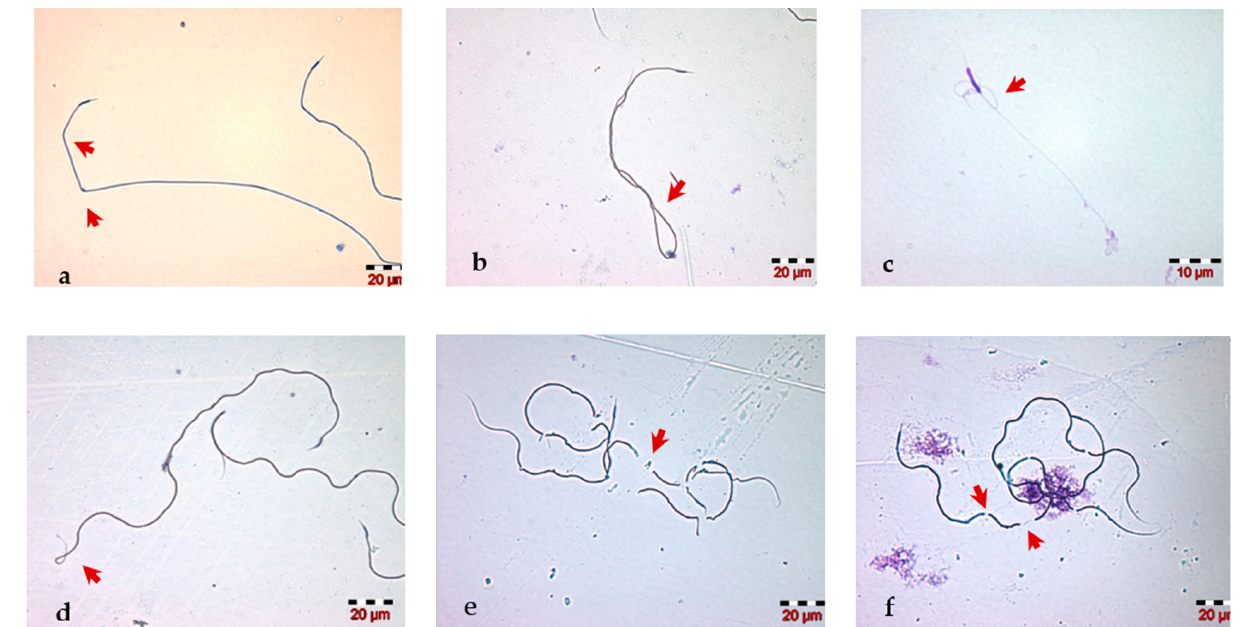
Figure 4. Microscopic images with abnormal morphology of spermatozoa tail: ( a ) bent, ( b , d ) coiled, ( c ) affected structure, ( e , f ) fragmented.